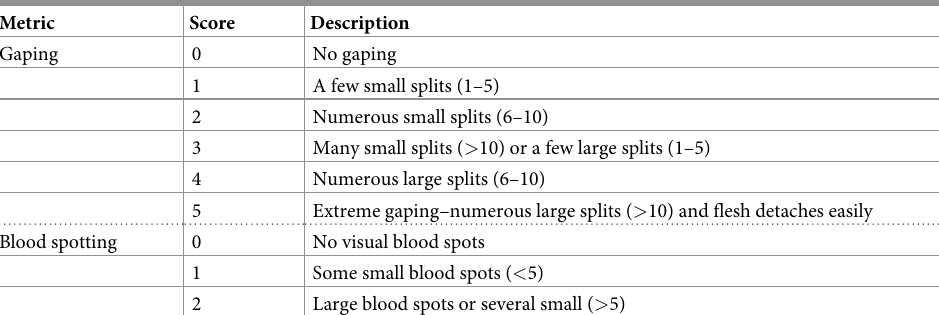
Table 2. Scoring system used for assessment of gaping and blood spotting. Gaping score methodology based on Grimsmo [52]. Blood spotting scoring adapted from Digre et al . [13].